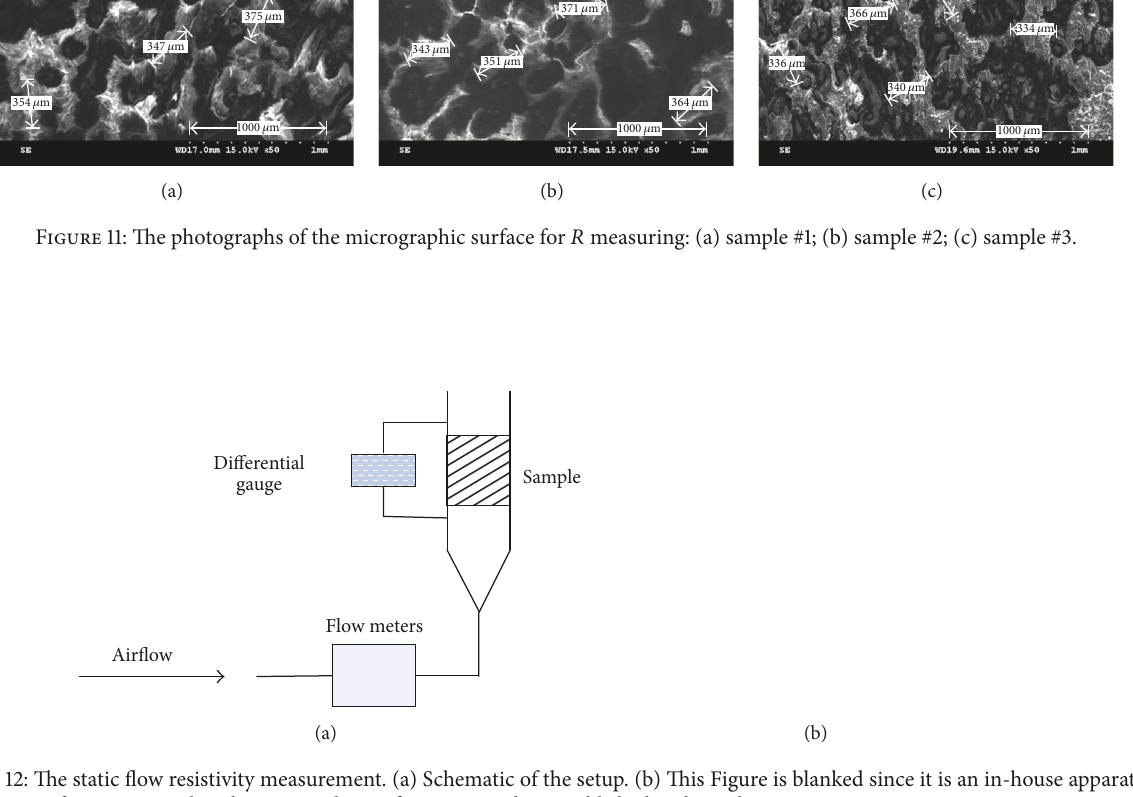
Figure 12: The static flow resistivity measurement. (a) Schematic of the setup. (b) This Figure is blanked since it is an in-house apparatus of the Institute of Acoustics at the Chinese Academy of Sciences and was published without their permission.